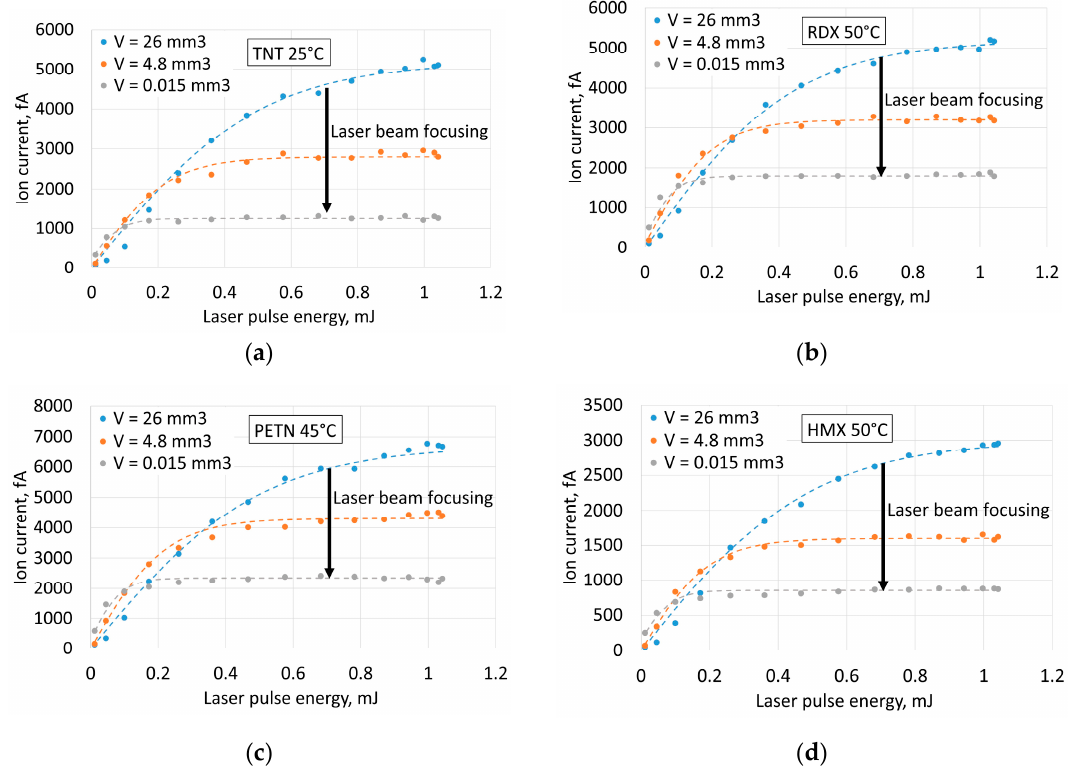
Figure 4. Amplitude of ion current in peaks of the explosives as a function of laser pulse energy at different volumes of illuminated space inside the ion source (beam volume): ( a ) TNT at 25 °C; ( b ) RDX at 50 °C; ( c ) PETN at 45 °C; ( d ) HMX at 50 °C.